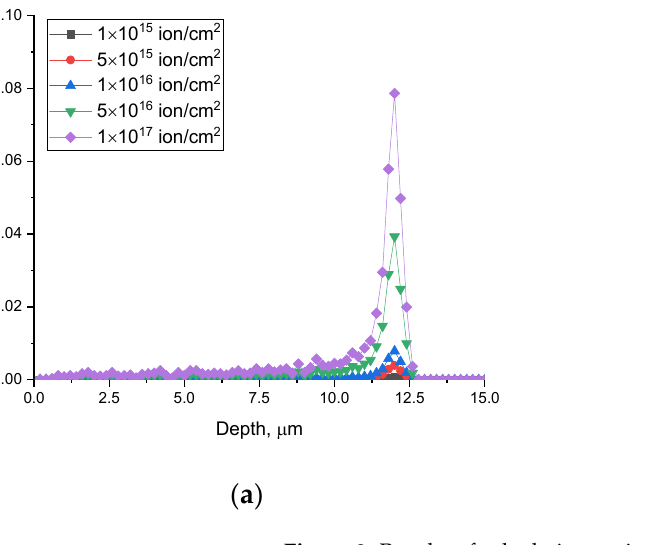
Figure 2. Results of calculations using the SRIM Pro 2013 program code: ( a ) calculations of the value of atomic displacements in the material of ceramics; ( b ) calculations of the concentration of implanted hydrogen by the depth of the path of incident particles.